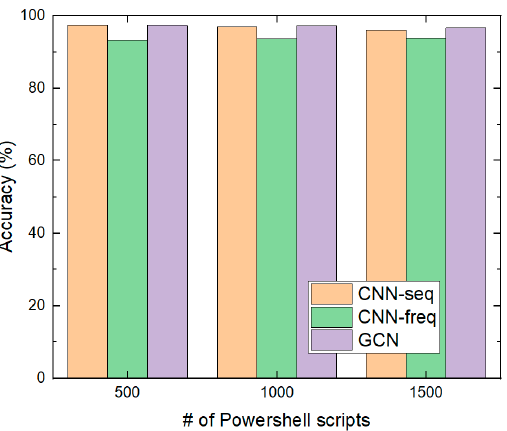
Figure 13. Comparison of GCN with Convolution Neural Network (CNN).